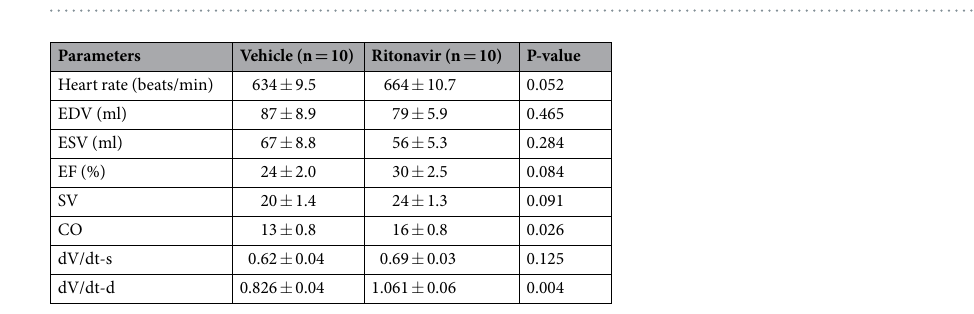
Figure 8. GLUT12 OE Cell Characterization and Effects of Ritonavir on GLUT12 Activity. ( A ) Quantitation of GLUT family members in GLUT12 overexpressing was determined as described in Methods. Glucose transport as determined by 2-DOG uptake was determined in vehicle-treated cells ( B ) or in the presence of increasing concentrations of ritonavir ( C ). Data represent the mean ± S.E. of three independent measurements and in ( C ) were normalized to fit by nonlinear regression analysis using GraphPad Prism software.